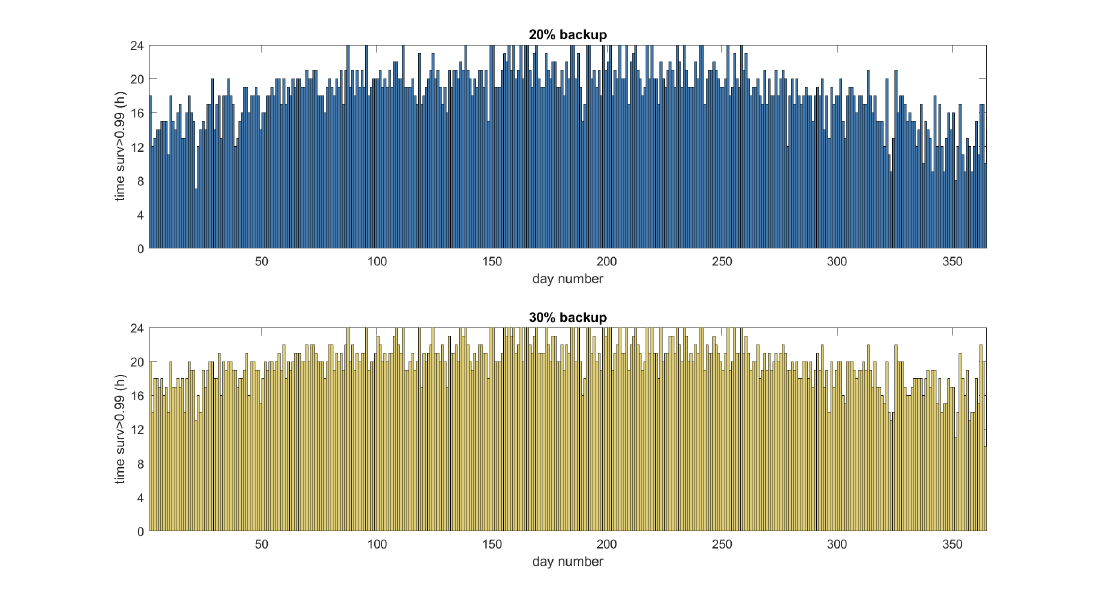
Figure 5. Number of hours per day that the energy system is survivable with a probability of at least 0.9 for a full year using the smart strategy with 20% and 30% backup capacity,